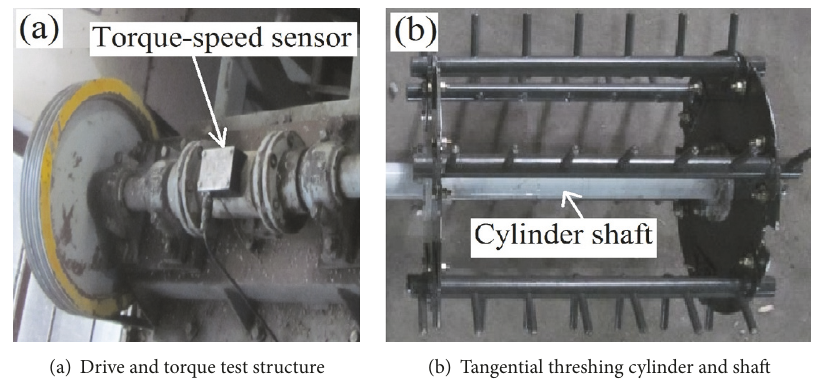
Figure 3: Drive and torque test structure of tangential threshing cylinder.